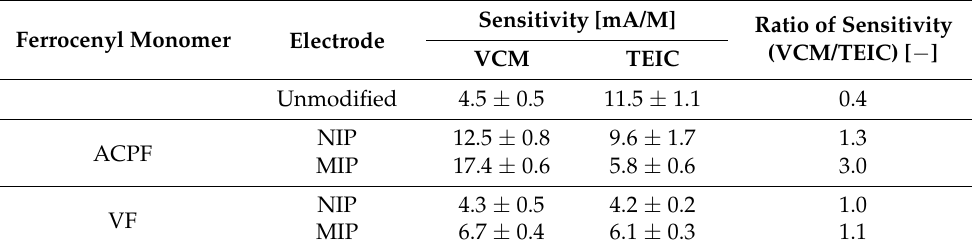
Table 2. Sensitivity to VCM or TEIC at each